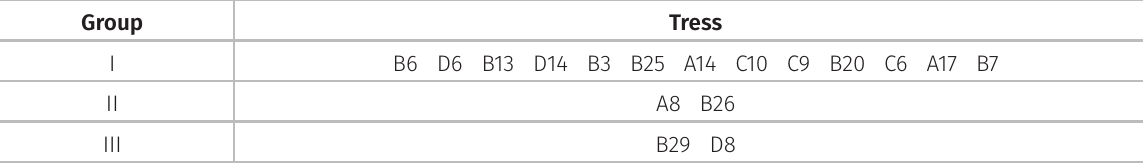
Figure 3. Dendrogram of the analysis of the 17 matrices of pequi tree by Unweighted Pair Group Method with Arithmetic Mean (UPGMA) obtained from the average Euclidean distance standardized for the eleven morphological characters of the fruits. CCC: Coefficient cophenetic correlation. Água Limpa Experimental Station - UFU, Uberlândia - MG,